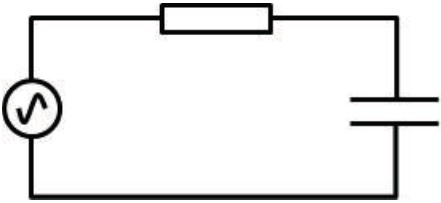
Figure 2. Electric diagram of a resistor capacitor